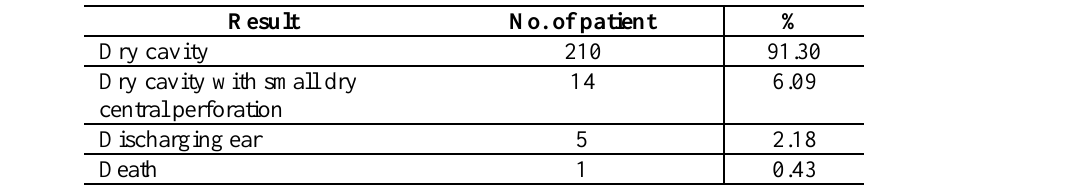
Table II : Results of operation (n=230)